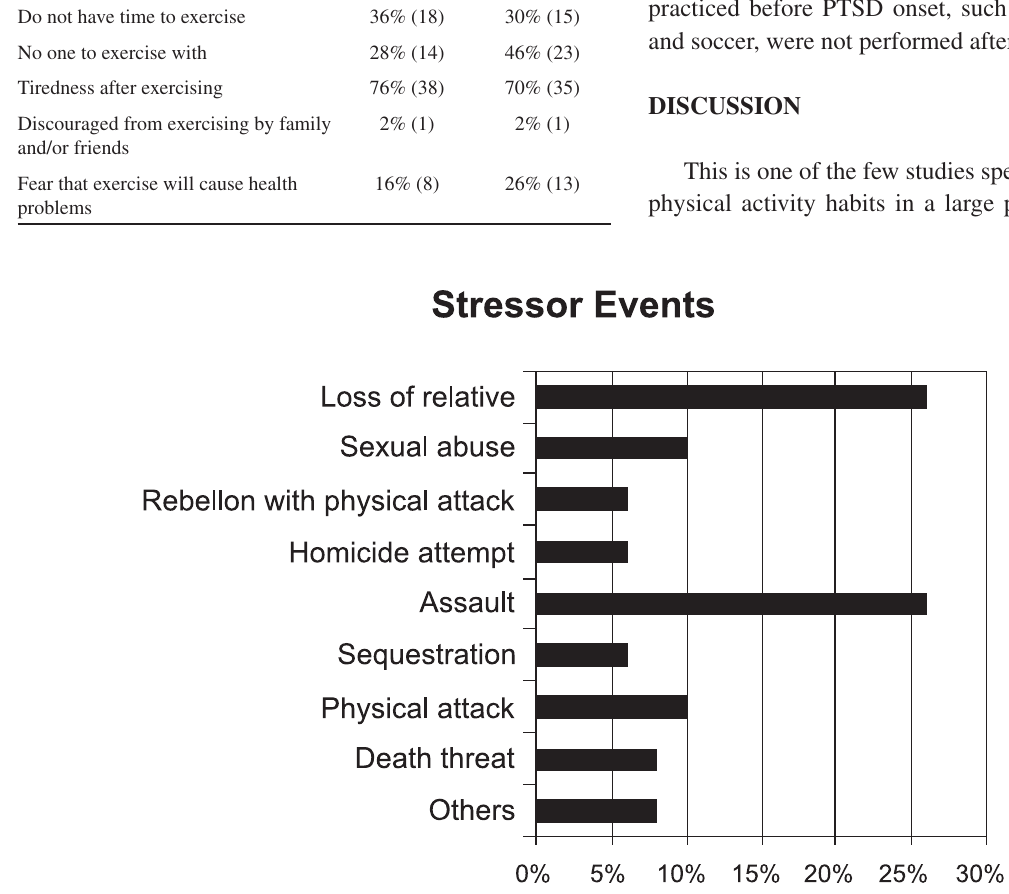
Figure 1 - Percentage of the main causes of PTSD pointed for the interviewed patients